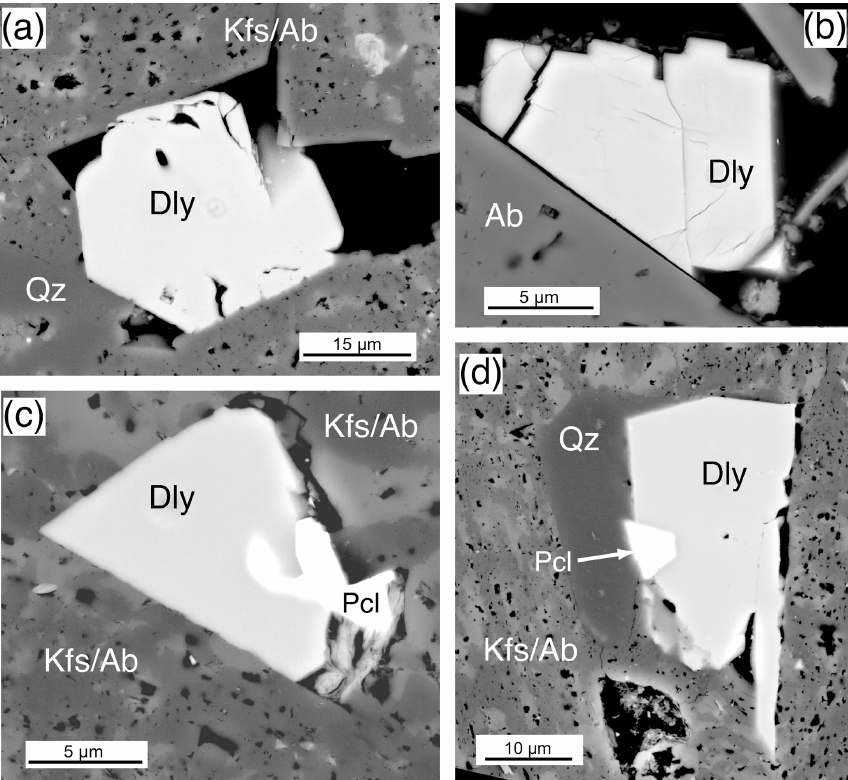
Figure 13. Dalyite, BSE images from sample DV24828, Ailsa Craig microgranite. (a) A 25µm dalyite (Dly) crystal precipitated in an open space formed by quartz (Qz) and inclusion-rich K-feldspar–albite (Kfs / Ab). (b) A euhedral, partially fractured, 15µm dalyite (Dly) that grew on albite (Ab) in open space. (c) A 15µm dalyite (Dly) that filled an open space coeval with fluornatropyrochlore (Pcl). (d) A 15µm dalyite (Dly) filling an open space in K-feldspar and albite (Kfs / Ab) coeval with quartz (Qz) and fluornatropyrochlore